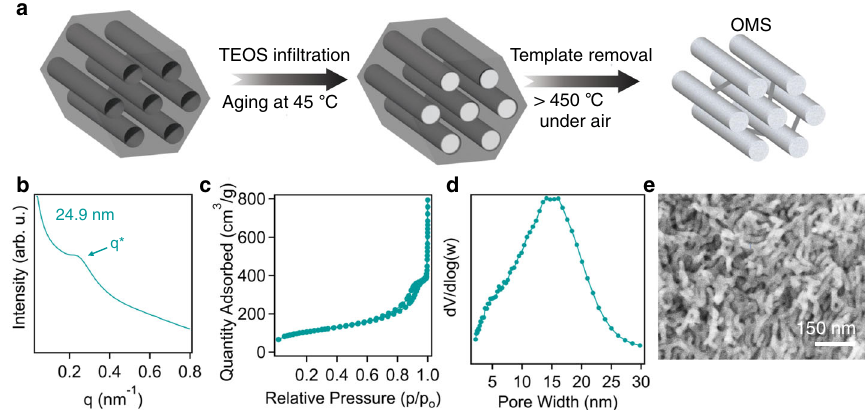
Fig. 5 | Synthesis of OMS from SEBS-derived OMC templates. a Schematic illus- trationofOMSsynthesiswhereOMCsarein fi ltratedwithasilicaprecursorwhichis then aged. Afteraging, the template is removed byexposureto high temperatures in air, resulting in mesoporous silica. ( b ) SAXS pattern, ( c ) nitrogen adsorption/